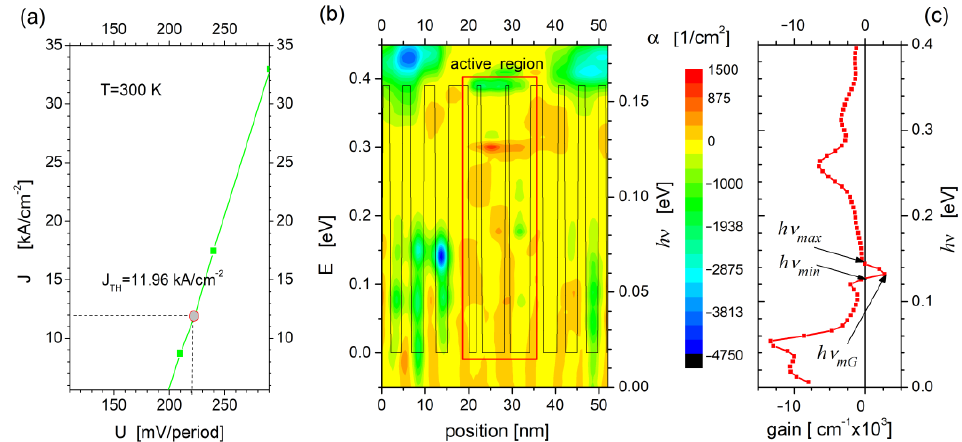
Figure 3. Simulation results of the QCL optical parameters calculated with RSM for the data in Table 1: Current–voltage characteristics and laser threshold current ( a ); the optical gain energy map ( b ) dependence of optical gain on the energy h ν ( c ) for voltage U = 220 mV/period. Table 1. The basic parameters of the QCL simulation for the results presented in Figures 2–4. Well